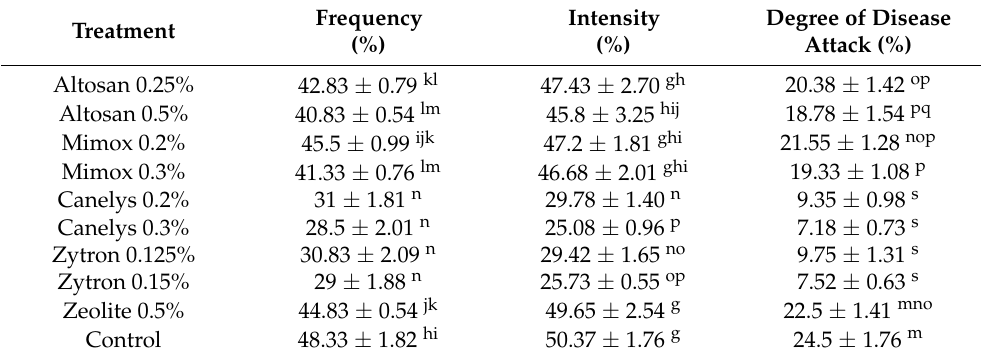
Table 5. ‘Thorn Free’ blackberry variety response to rust disease treatments applied during 2018–2019.